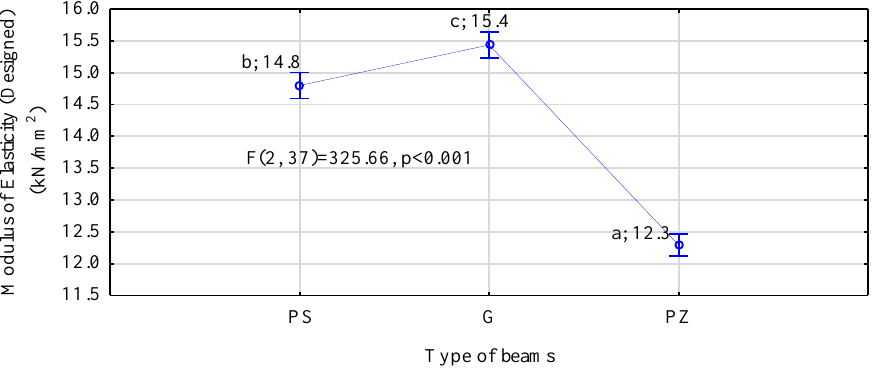
Figure 7. ANOVA of the designed modulus of elasticity of beams reinforced with rods (a, b, c let- ters mark homogenous groups in the HSD Tukey test).